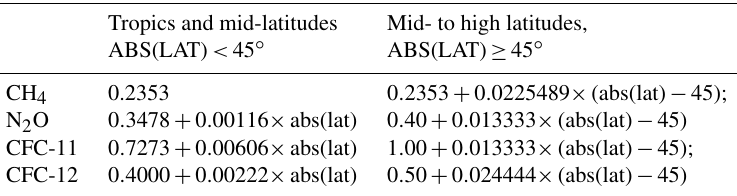
Tropics and mid-latitudes Mid- to high latitudes, ABS(LAT) < 45 ◦ ABS(LAT) ≥ 45 ◦